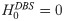
Period doubling transition in the reduced model.(A) β-Power as a function of the stimulation frequency (fDBS) using the pulse width δ as a parameter. The β-Power has been normalized with respect to that obtained for the system in the oscillatory state without stimulation (H0DBS=0). The solid vertical line indicates the stimulation frequency at which the period doubling bifurcation occurs (fd). (B) Synaptic current I1 when fDBS = 30 Hz + ϵ (top), fDBS = 30 Hz − ϵ (bottom), where ϵ ∼ 0.6 Hz.